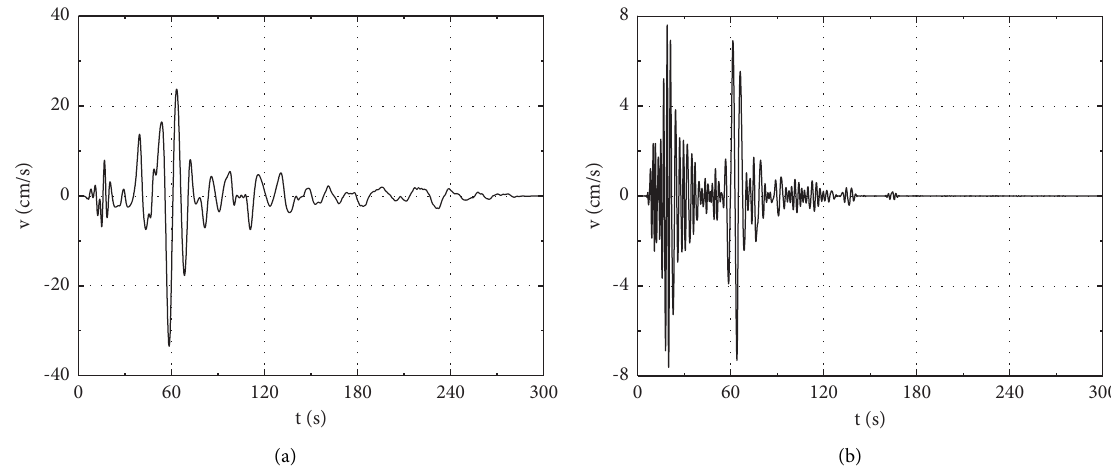
Figure 15: 4 Hz frequency threshold. (a) The low-frequency signal. (b) The high-frequency signal.